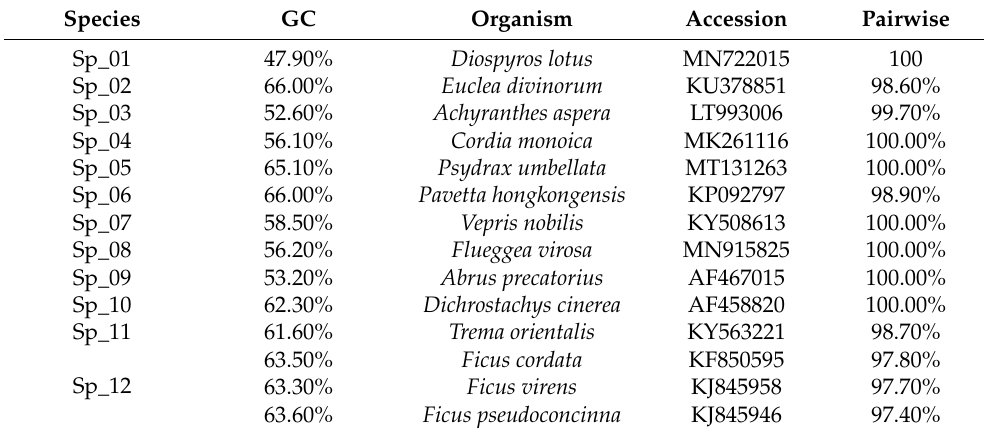
Table 2. Blast results of the ITS sequences of 12 rare species of the Faifa mountains. Species GC Organism Accession Pairwise Sp_01 47.90% Diospyros lotus MN722015 100 66.00% Euclea divinorum